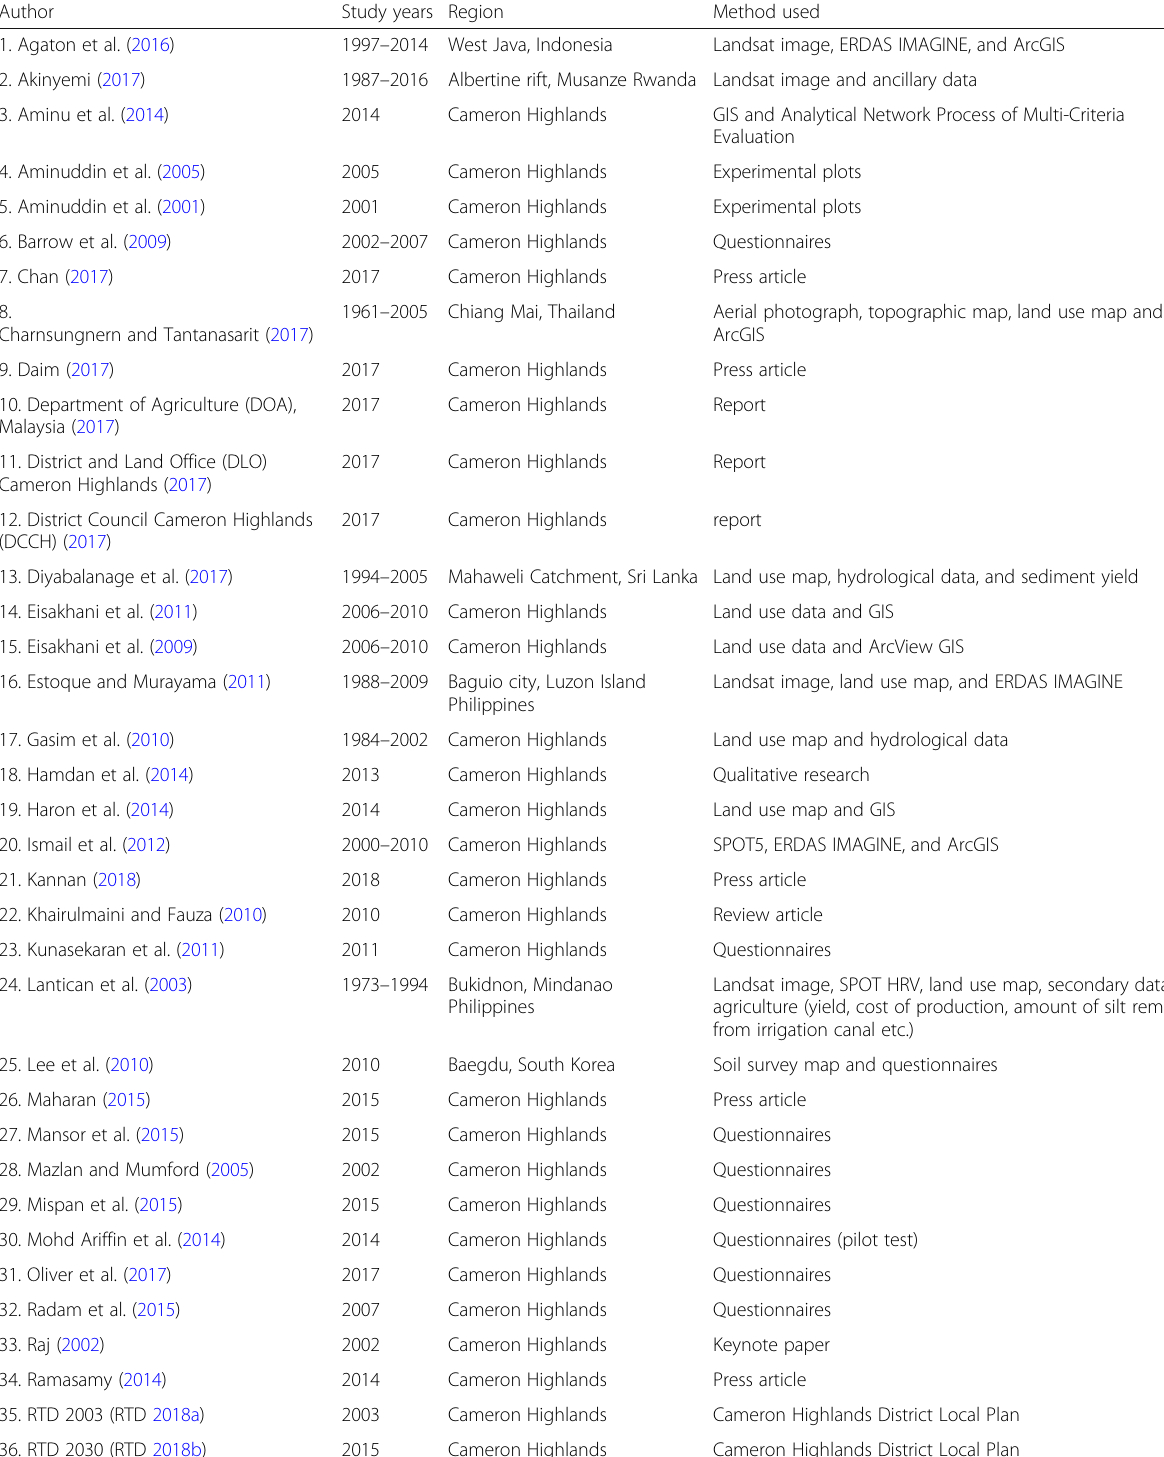
Table 6 Data for land use and land change studies (including agriculture practices, agro-tourism, and policy and